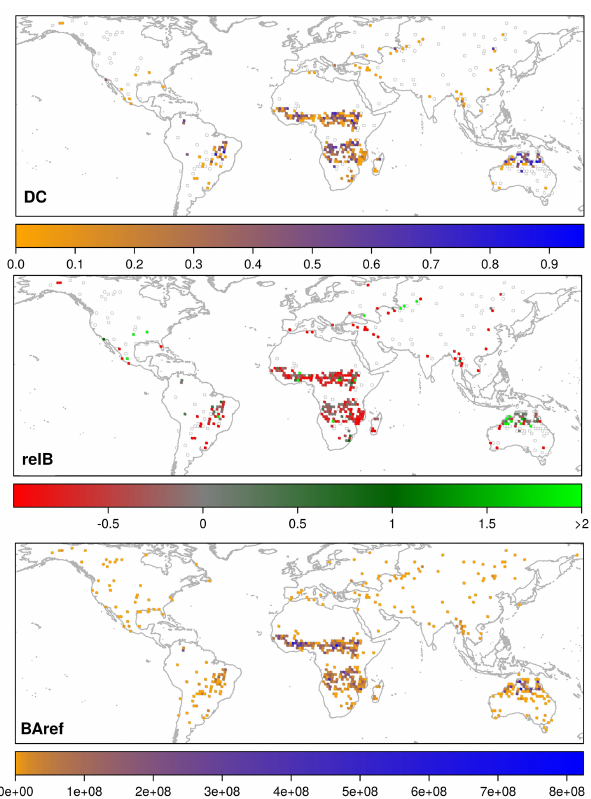
Figure 5. Dice coefficient (DC), relative bias (relB) and reference burned area (BAref; m 2 ) for FireCCI50 in TSAs. TSAs with refer- ence data but without accuracy measurements available are repre- sented by empty polygons (white polygons with grey borders). DC is not available when there is no BA in the reference data or in the product, and relB is not available when there is no BA in the refer- ence